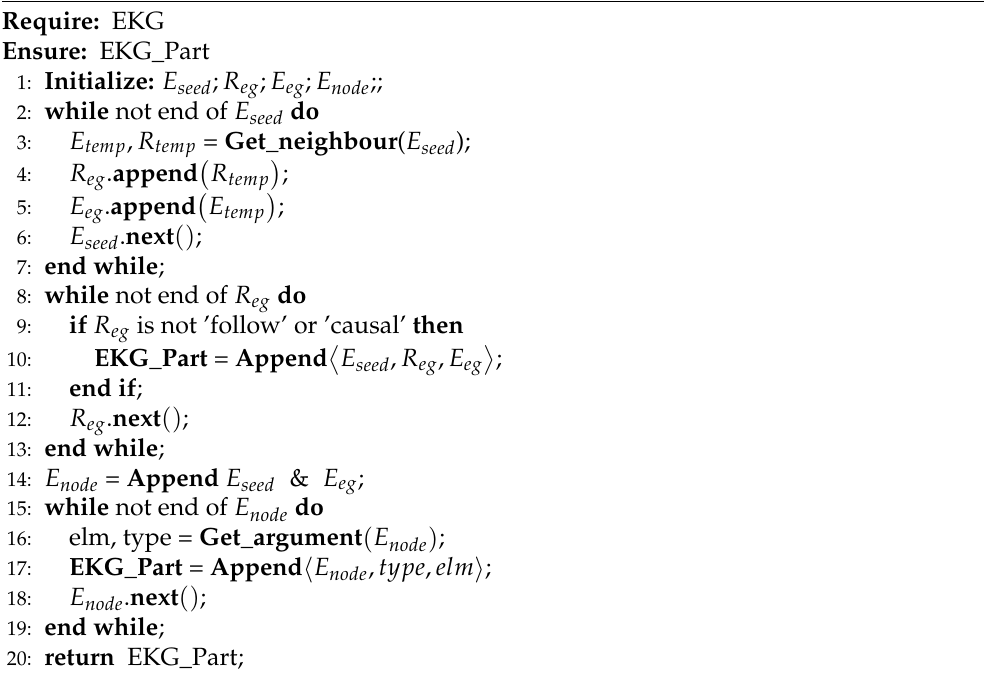
Algorithm 1 Event subgraph extraction.